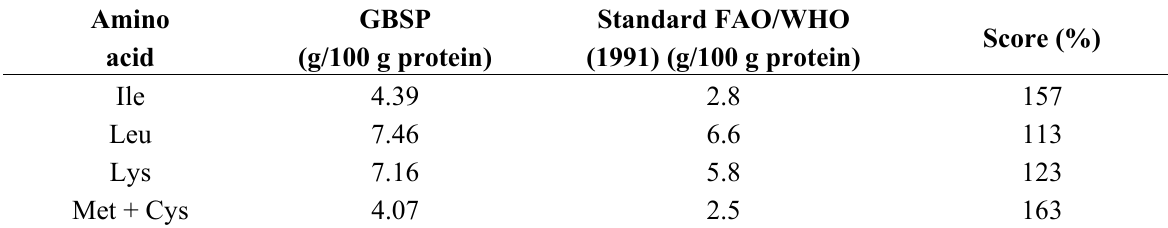
Table 3. Amino acids score (%) of purified protein (GBSP)